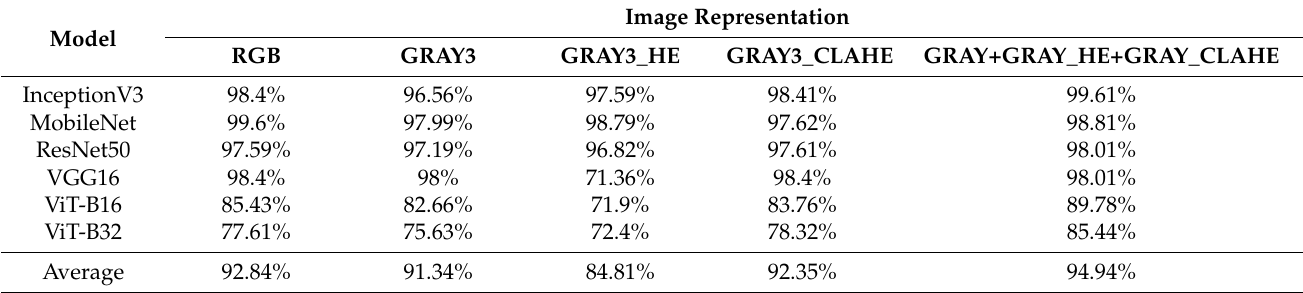
Table 4. Precision of the models across various image